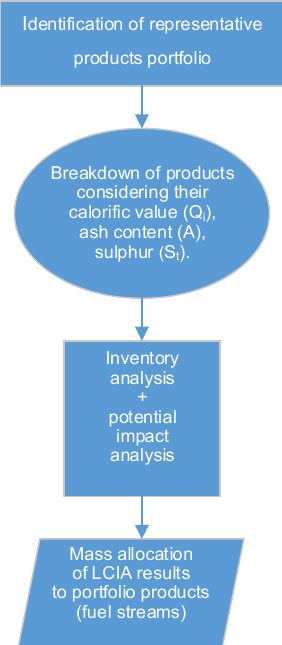
Figure 2. Algorithm of the procedure for the mining module in the model (LCIA—Life Cycle Impact Assessment, Q i —calorific value, A—ash content, S t —total sulphur content).